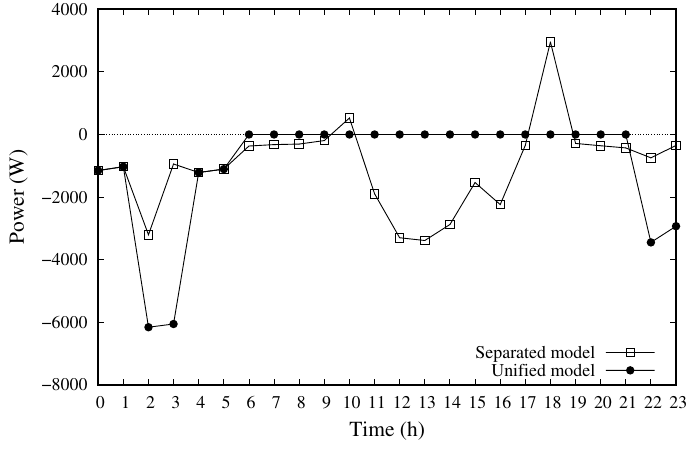
Figure 6. Daily profile of the community for Separated and Unified models.